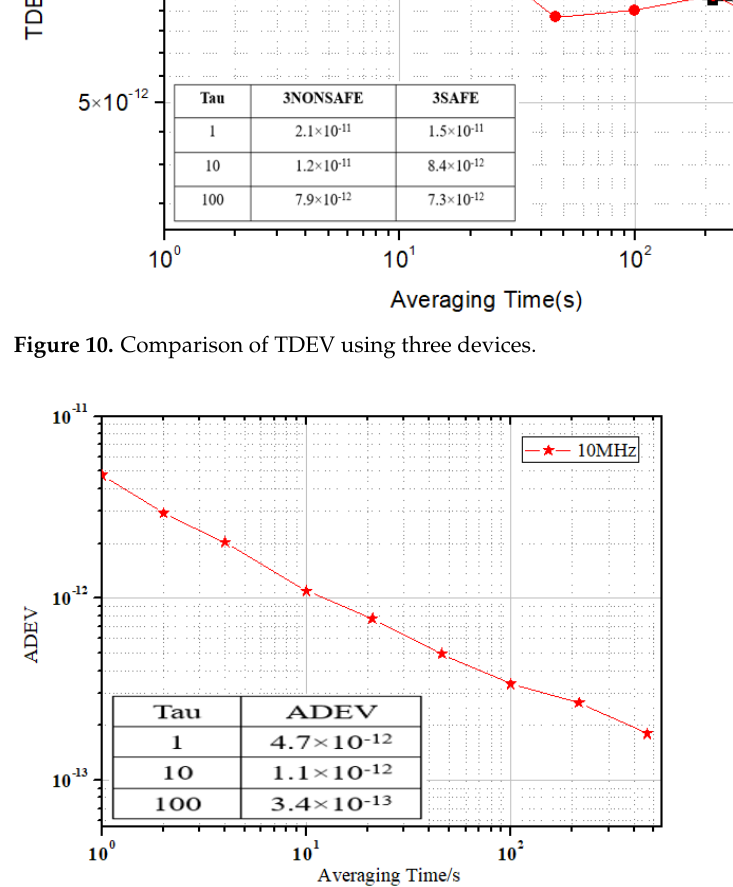
Figure 11. Diagram of ADEV in 10 MHz.